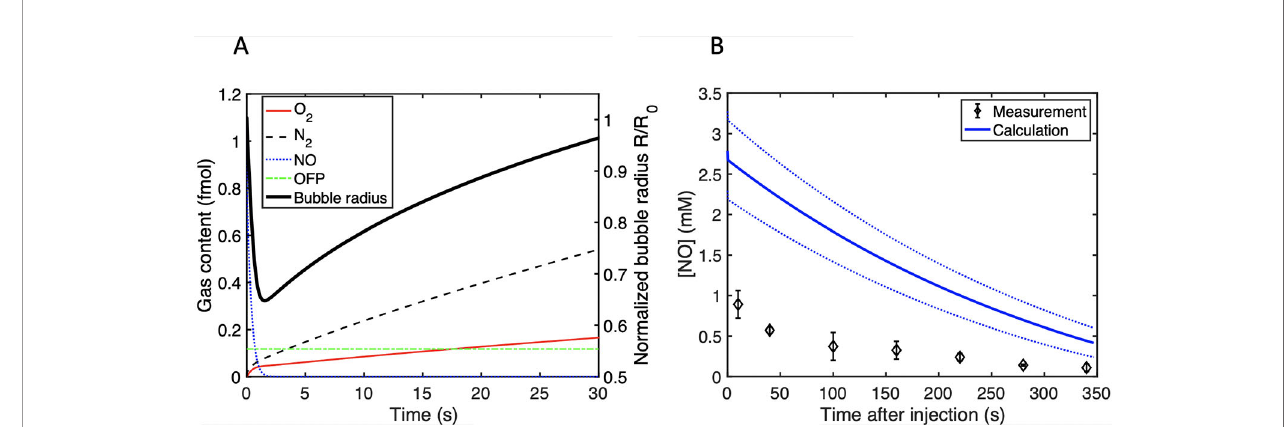
FIGURE 5 | (A) The gas content in femtomoles inside a single 3.5-µm diameter bubble and the normalized radius as a function of time after immersion in air- saturated water. (B) Calculation of the time-dependent NO concentration in the 96 well-plate used to assess bactericidal activity. The initial NO concentration was determined from the size measurements. The dotted lines represent the range of the NO concentration calculated based on the standard deviation in the size distribution